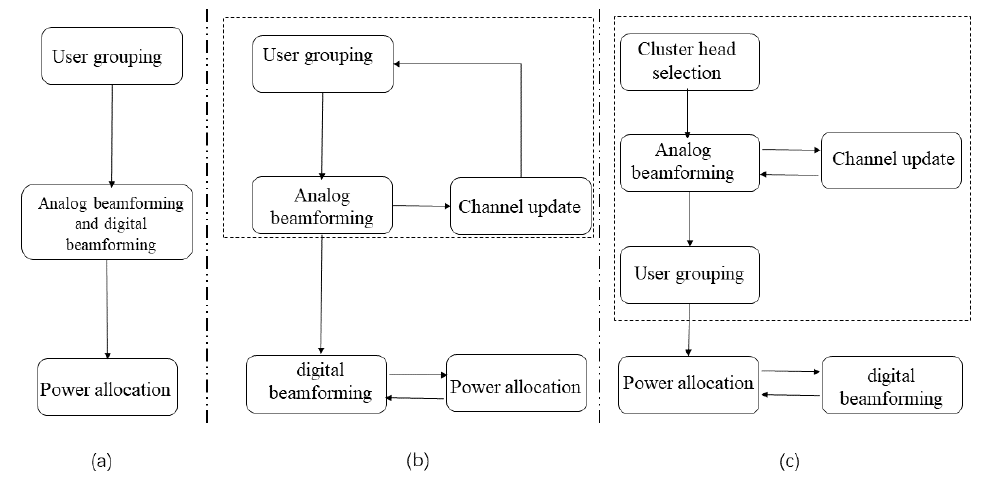
Figure 3. Comparison of the hybrid beamforming NOMA design procedure: ( a ) the traditional hybrid beamforming NOMA design, ( b ) the S-AGNES hybrid beamforming NOMA design (Reprinted with permission from Ref. [21]. 2021, Zhu, J), ( c ) the proposed hybrid beamforming NOMA